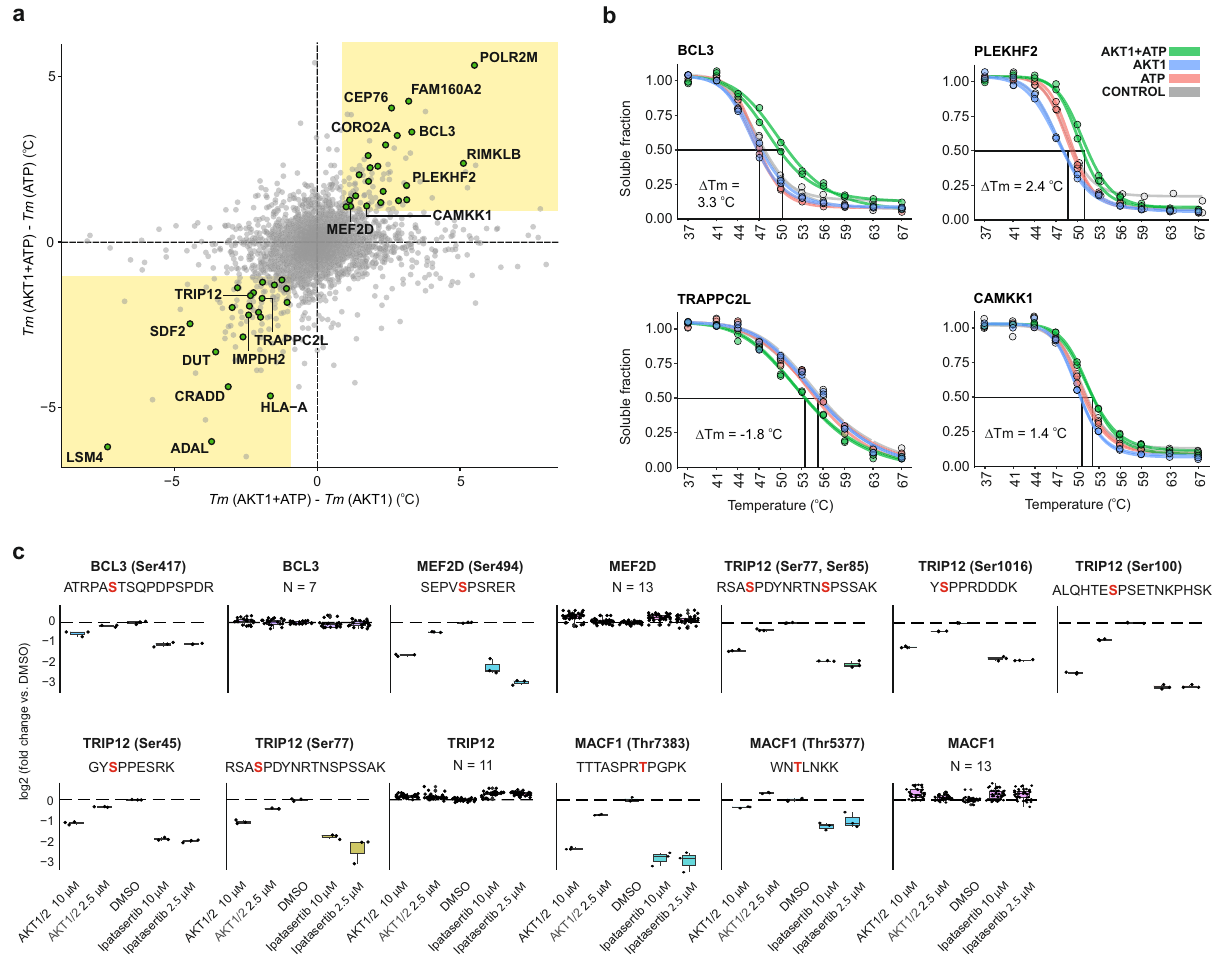
Fig. 3 SIESTA identi fi ed known and putative substrates for AKT1 kinase. a Scatterplot of T m differences reveals the T m shifts occurring only after simultaneous AKT1 + ATP addition (known and putative substrates are shown as green circles). b Representative melting curves for known and putative AKT1 substrates. c The reduction in the phosphorylation level of AKT1 substrate proteins by AKT1/2 inhibitor and ipatasertib treatment at 2.5 and 10 µ M (all shown peptides are signi fi cant under all compound treatment conditions vs. DMSO condition ( p < 0.05); n = 3 indepe n dent biological replicates, two- sided Student t -test). The phosphorylation levels of other phosphopeptides detected for the same proteins are compiled into one plot. N denotes the number of unchanged phosphopeptides for each protein. (Center line — median; box limits contain 50% of data; upper and lower quartiles, 75 and 25%; maximum — greatest value excluding outliers; minimum — least value excluding outliers; outliers — more than 1.5 times of the upper and lower quartiles) (AKT1 RAC-alpha serine/threonine-protein kinase or protein kinase B, ATP adenosine triphosphate, Tm melting temperature). Source data are provided as a Source Data fi le.